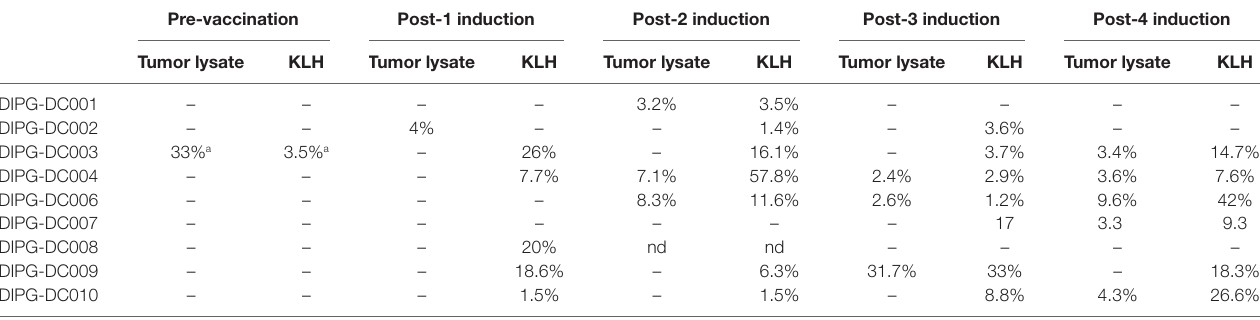
TaBlE 3 | Percentage (%) of proliferating T-cells from PBMCs labeled with 5,6-carboxyfluorescein diacetate succinimidyl ester-dilution in response to tumor cell line lysate or KLH after substraction of signal in unstimulated control. Pre-vaccination Post-1 induction Post-2 induction Post-3 induction Post-4 induction Tumor